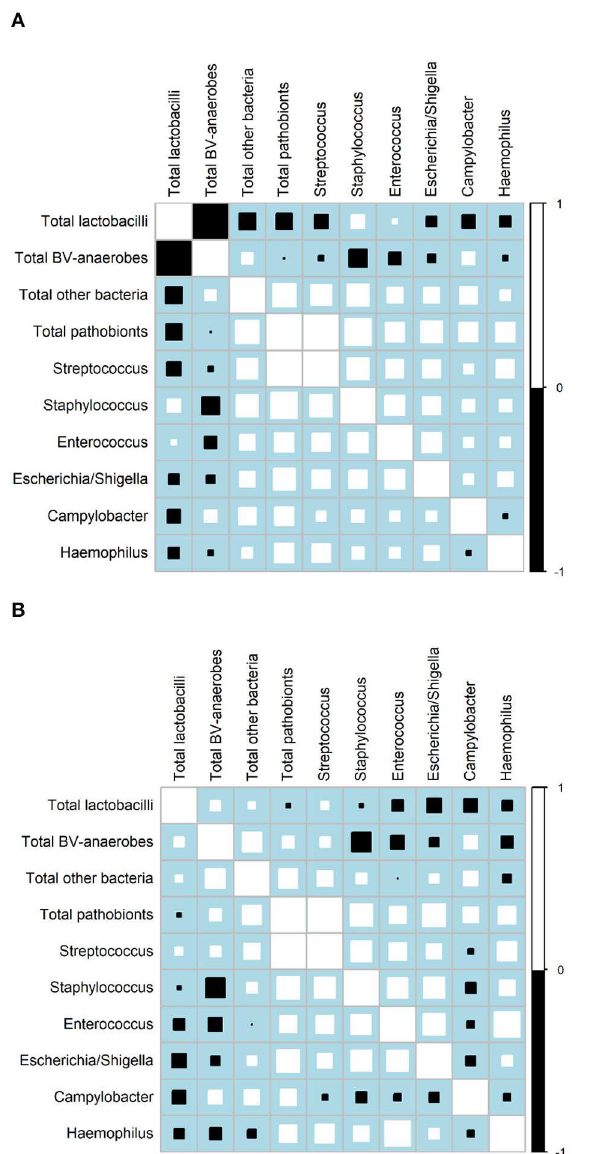
FIGURE 2 | Correlation matrices. (A) Relative abundances, all three studies ( N = 1,781 samples) a . (B) Estimated concentrations, VMB study only ( N = 158 samples) a . BV, bacterial vaginosis. a Only includes VMB samples not influenced by the interventions, collected at Screening, Month 6, and Month 1 and 2 in the no-intervention group. Squares indicate the Spearman’s rank correlation between − 1 and + 1. Positive correlations are shown in white and negative correlations in black. The size of each square is loosely proportionate to the magnitude of the correlation. For the actual correlation coefficients, (see Supplementary Material , Tables S2C,D